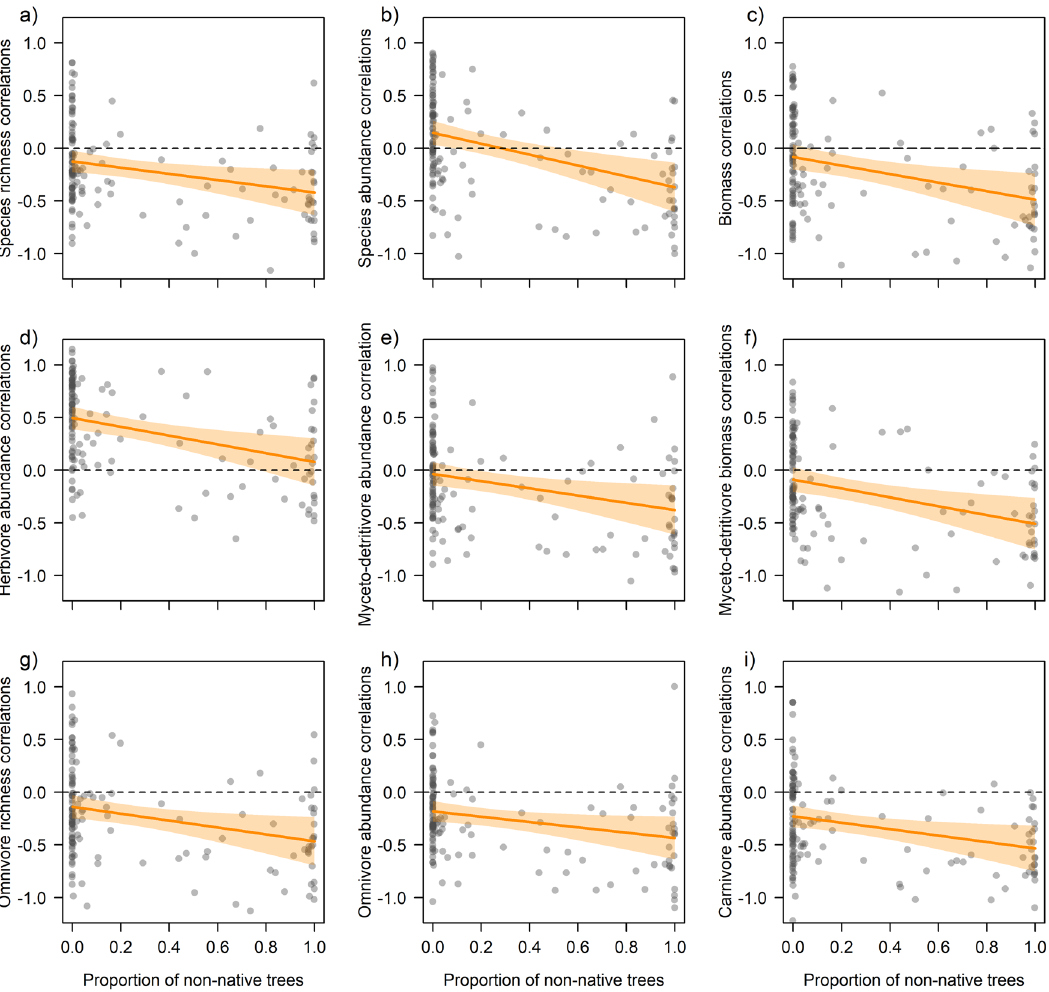
Fig. 2 Results for site-level correlations and the proportion of non-native trees. The proportion of non-native trees per site was related to site-level correlations (each shown as partial residuals of Pearson ’ s r between year and the respective community response) in insect populations, with sites characterized by more non-native trees having more negative (or less positive) correlations in a total insect species richness, b total insect abundance, and c total insect biomass. The relationship with non-native trees was found for all trophic groups as indicated for d herbivore abundance, e myceto-detritivore abundance, f myceto-detritivore biomass, g omnivore species richness, h omnivore abundance, and i carnivore abundance. Note that even for d herbivores, which had positive correlations with time, abundance correlations on sites with more non-native trees were lower. Full statistical details are available in Supplementary Data 1. Regression lines (95% CI in shaded polygons) indicate the marginal predictions of linear mixed-effects models. Dashed horizontal lines mark null with negative values indicating sites with declining and positive values sites with increasing community responses over